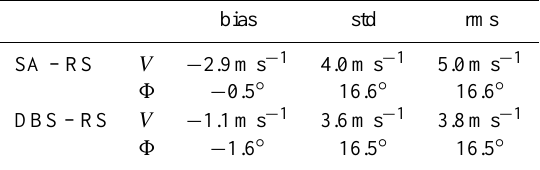
Table 2. Comparison of winds obtained from spaced antenna (SA) and Doppler beam swinging (DBS) methods of the ALWIN VHF radar and radiosonde measurements in the altitude range between 2 and 8km (bias, standard deviation, and rms